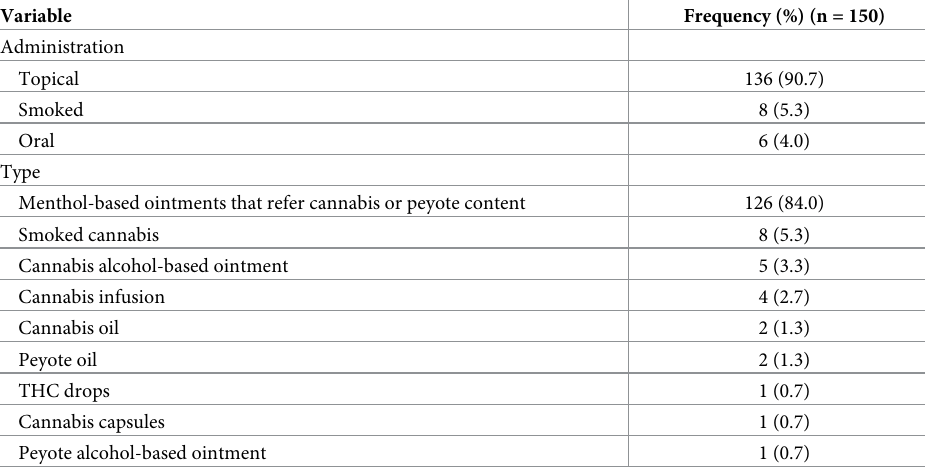
Table 3. Use of cannabis-related